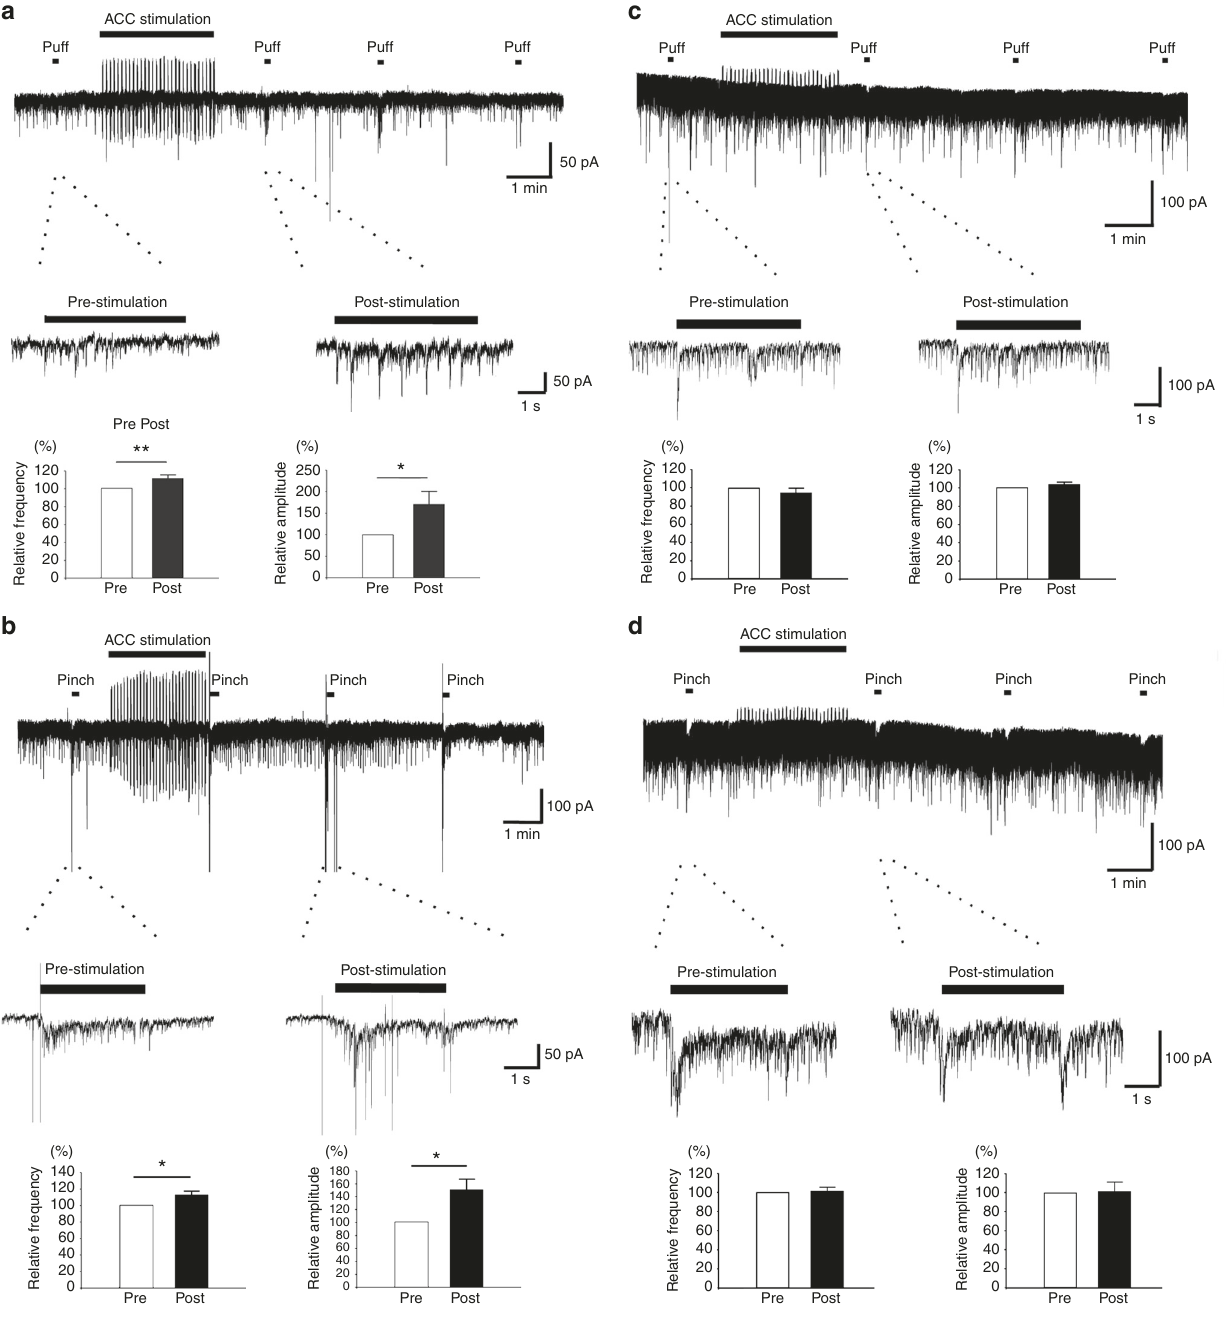
Fig. 7 ACC stimulation potentiated the primary afferent stimulation induced EPSC of SDH neurons. a One recording sample and summarized results (9 SDH neurons) showing that ACC electrical stimulation increased the frequency and amplitude of puff induced EPSC. * p = 0.04; ** p = 0.006, paired t -test. b One sample and summarized results (10 SDH neurons) showing ACC electrical stimulation increased the frequency and amplitude of pinch induced EPSC. *frequency: p = 0.04; amplitude: p = 0.03, paired t -test. c One sample and summarized results (7 SDH neurons) showing ACC electrical stimulation did not affect the frequency and amplitude of puff induced EPSC. d One recording sample and summarized results (7 SDH neurons) showing ACC